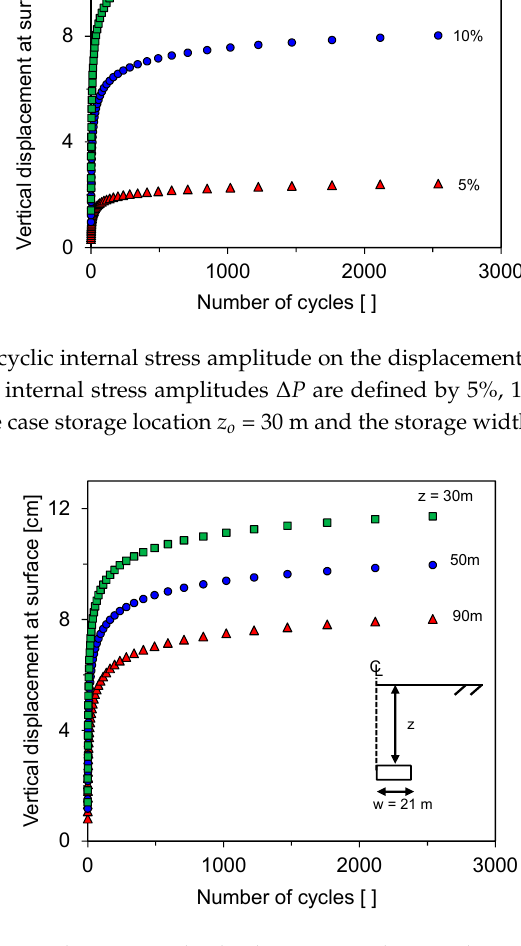
Figure 8. The effect of storage width on the displacement evolution. The case storage location z o = 30 m and cyclic stress amplitude Δ P/P avg = 10%.